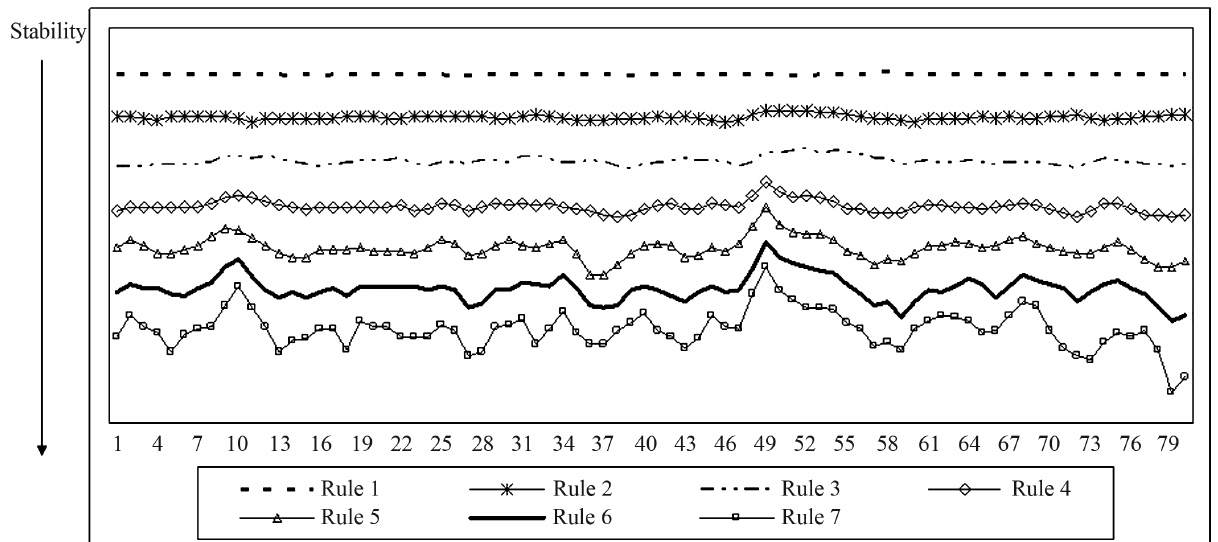
Figure 8 - Plot for the stability-based simulation data. This plot represents the rule prototype obtained with the FAGNIS method for rule extraction. Only rule 1 is for non-promoter sequences; the other rules are for prototype promoter